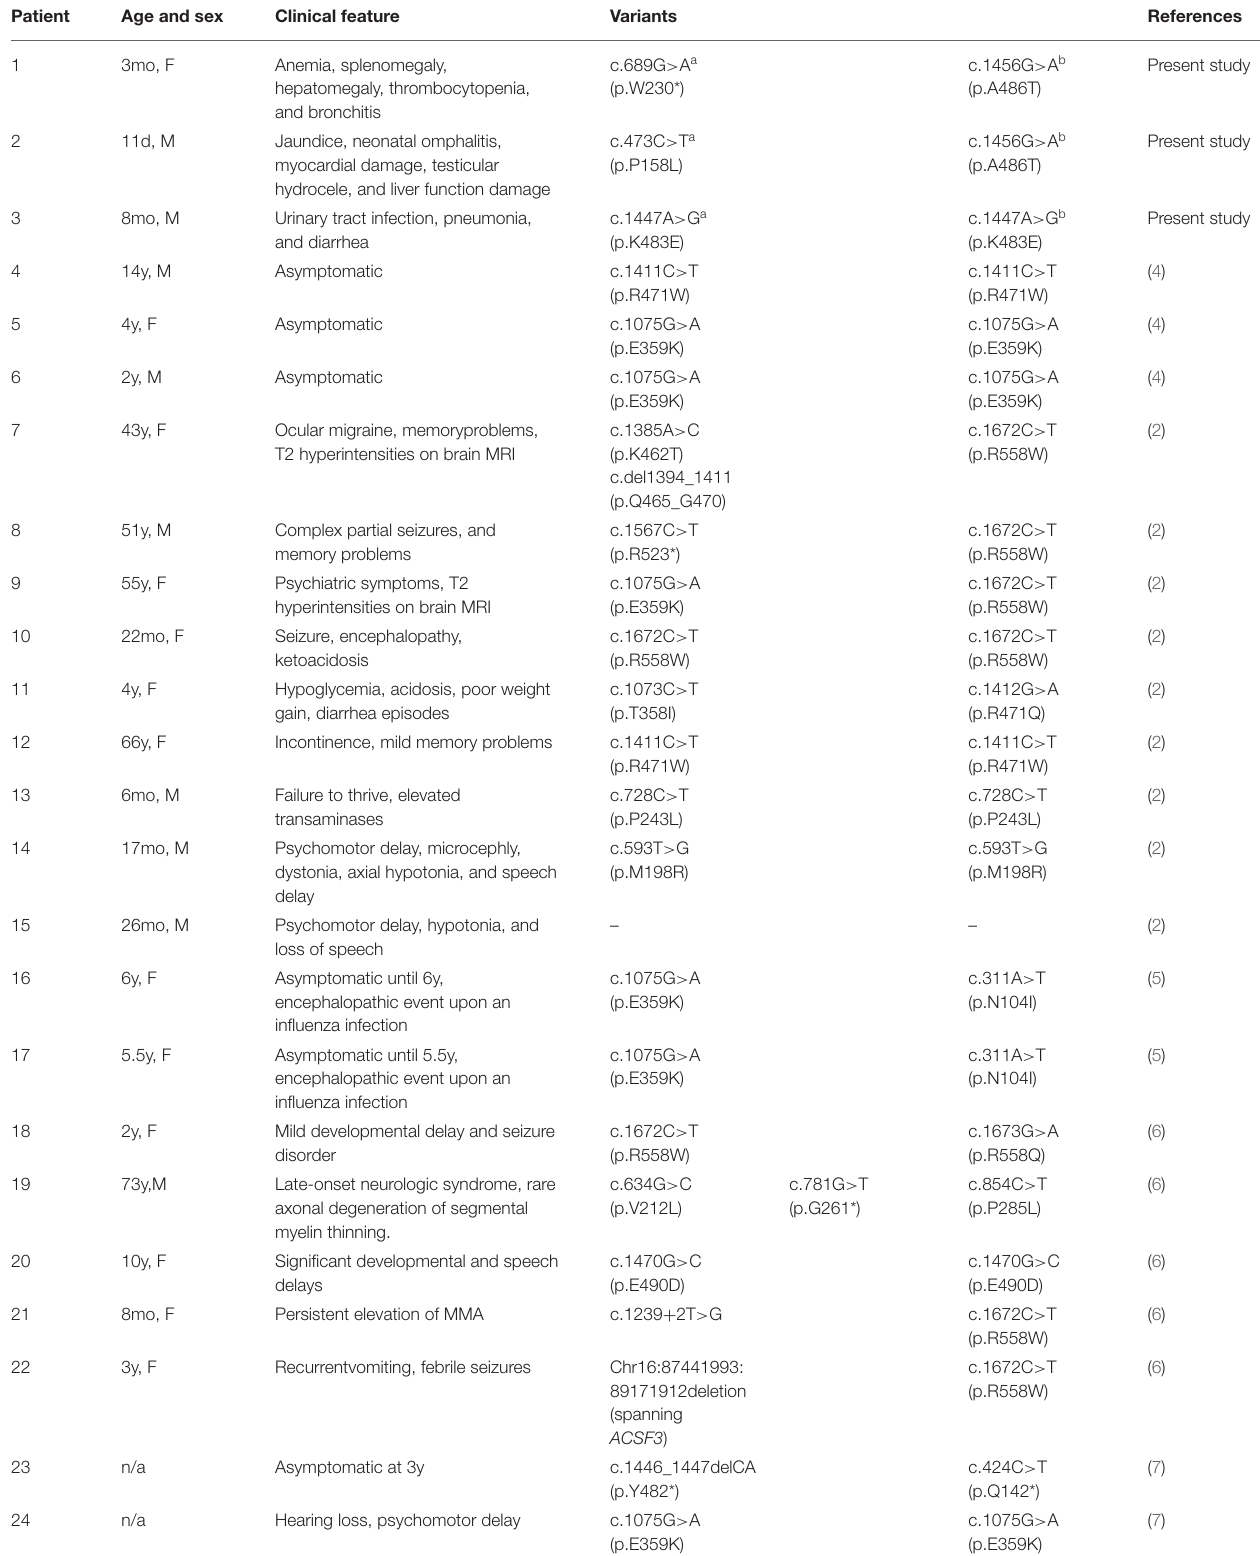
TABLE 1 | Genetic and phenotypic finding of patients with CMAMMA.